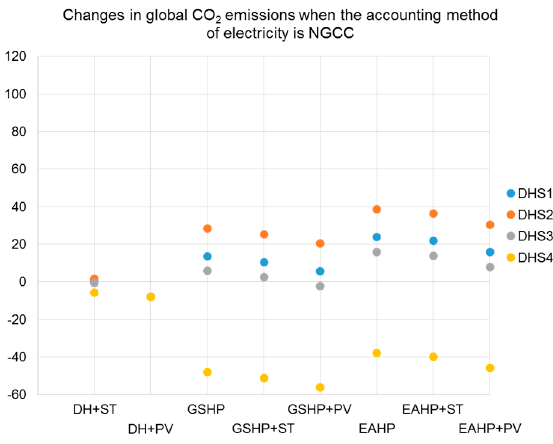
Figure 4. The changes in global CO 2 emissions for different heating sources and if an ST or a PV system is used, compared to if the building is heated with DH only. The four different compositions of DHS presented in Table 4 are compared and the allocation for changes in electricity use/production is NGCC. The yellow DHS 4 marking for DH + PV represents all four systems.